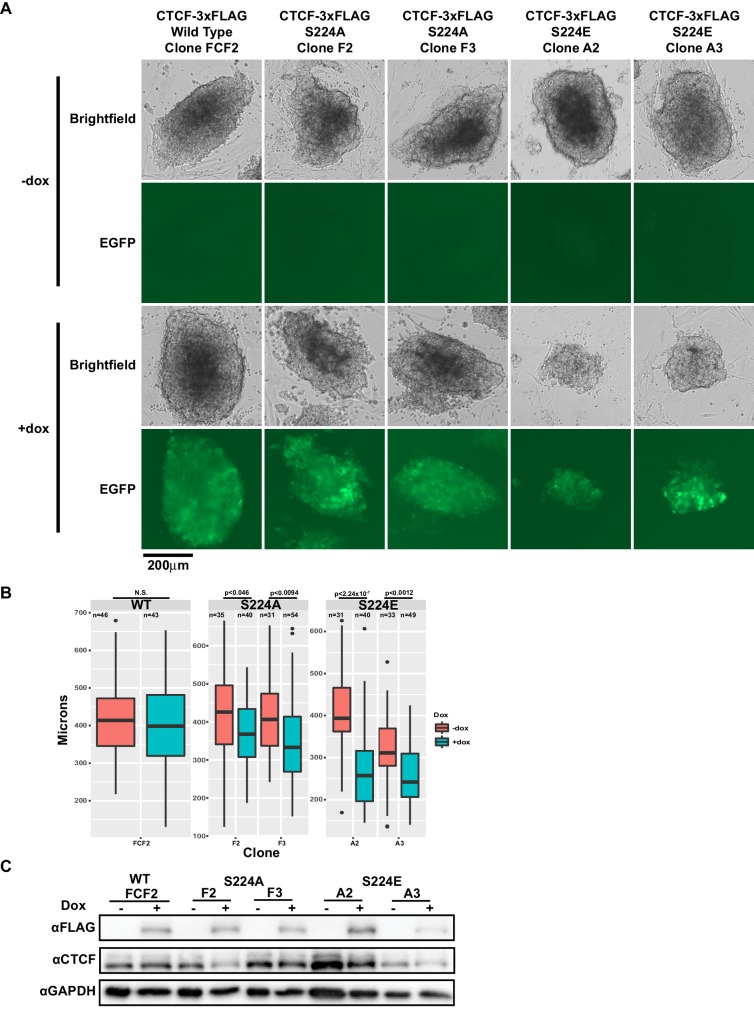
CTCF S224E phosphomimic mutation is poorly tolerated by dividing cells.(A) Representative brightfield and EGFP images of F1-2.1 mESCs carrying a dox-inducible wild type CTCF, S224A or S224E transgene grown for six days with (bottom) or without (top) doxycycline. Two independent S224A and S224E clones are shown. (B) Quantification of colony diameters in microns of cell lines shown in (A), grown for six days with (blue) or without (red) doxycycline. Student’s t-test was used to calculate p-values between indicated samples, with not significant (N.S.) p-values being >0.05. (C) Western blot measuring FLAG and CTCF protein levels of cell lines shown in (A). GAPDH is shown as a loading control.